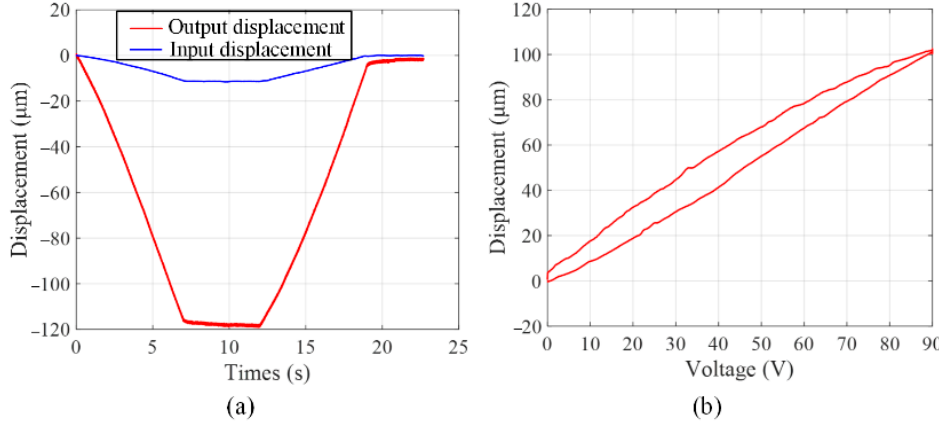
Figure 5. Open-loop tests of ( a ) amplification ratio test, ( b ) hysteresis nonlinearity test.